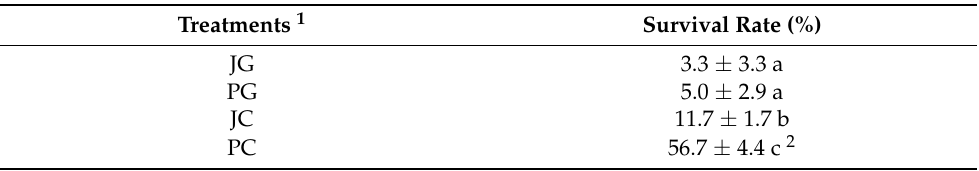
Table 3. The survival rate of M. maritima plants from the jar (J) or Plantform (P) and acclimatized in a greenhouse (G) or in a growth chamber